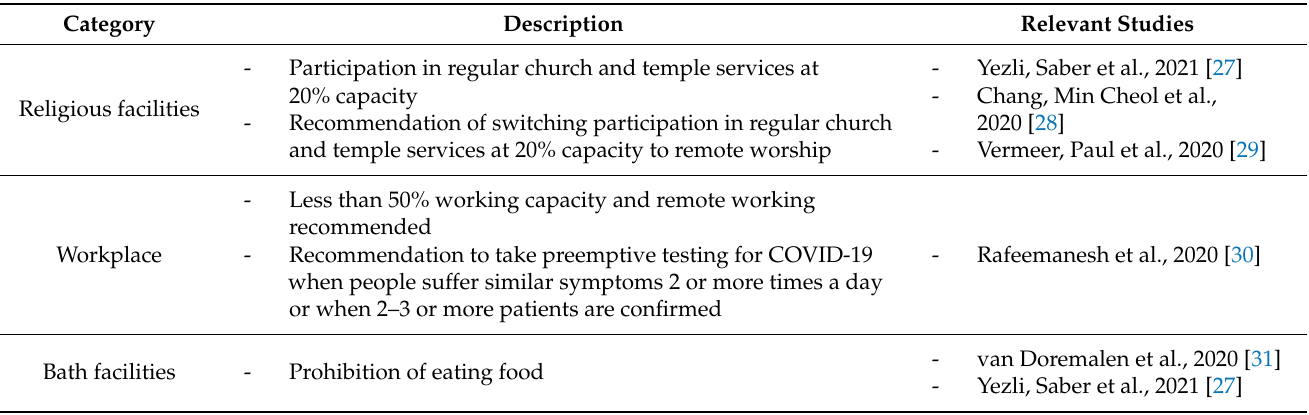
Table 1. Implementation of Seoul-style precision disease control and prevention for 10 types of facilities and related